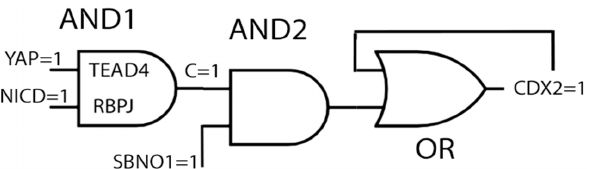
Figure 1. Logic gates of the trophectoderm enhancer of the CDX2 gene. The TE enhancers in cells of the >8-cell embryos contains the nuclear targets, TEAD4 and RBPJ, as part of the AND1 gate. The signal chain factors, YAP (part of HIPPO) and NICT (part of NOTCH), are variable gate input factors. Positive input triggers the output, C = 1. The ensuing AND2 gate induces the transcription of CDX2, if the gate input is C = 1 and SBNO1 = 1. If YAP = 0, NICT = 0, or SBNO1 = 0, there will be no CDX2 induction. The CDX2 protein induces gene expression in a positive feedback loop